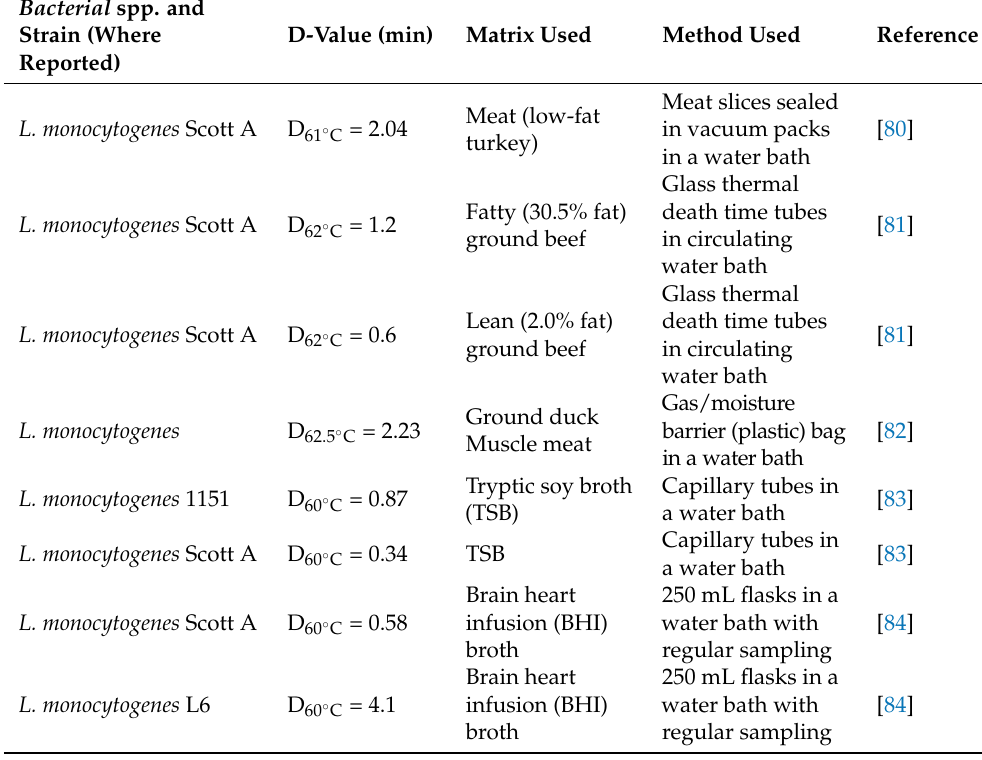
Table 6. Summary of D-values (thermal resistance) for L. monocytogenes along with the matrix used. Bacterial spp.